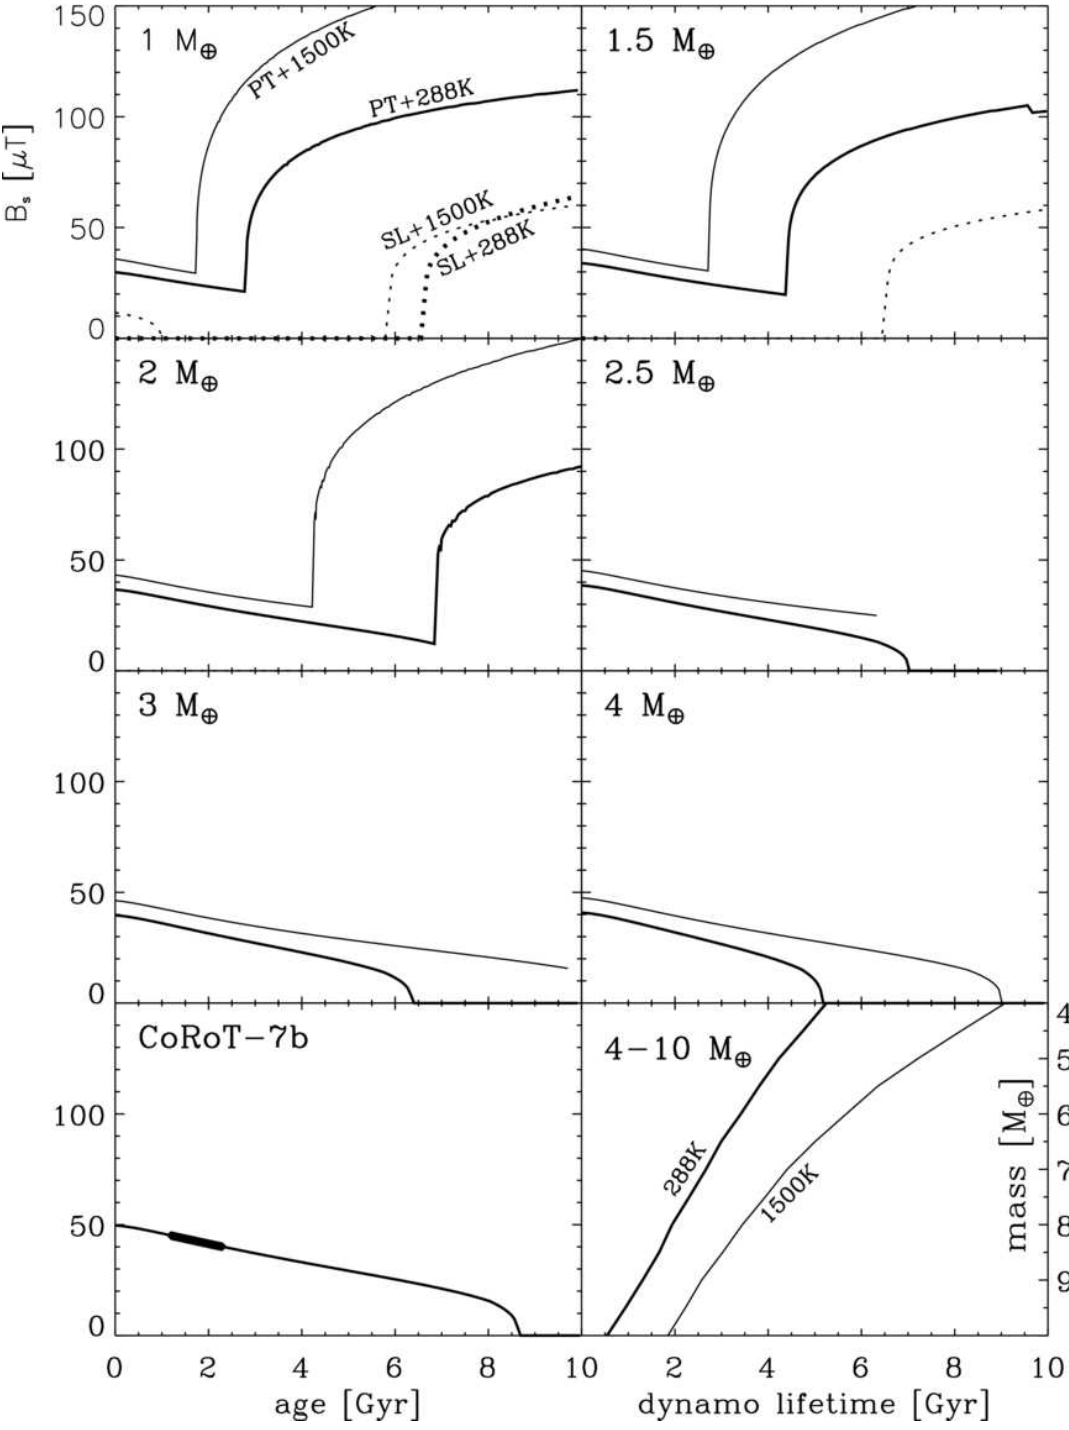
Figure 6. Evolution of the surface PMF of planets with masses of 1–10 M ⊕ and the ∼ 4.8 M ⊕ planet CoRoT-7b. Absence of a line indicates that the dynamo is inoperative. Dynamos are assumed dipolar. Heavy solid lines: Earth-like planets with plate tectonics and T = 288 K. s Light solid lines: a hot Earth with plate tectonics and T = 1500 K. Light dashed lines: Venus-like planets with stagnant lid, 10 times the s Earth’s mantle viscosity, and T = 1500 K. Heavy dashed lines: a balmy Venus with T = 288 K. For the case of CoRoT-7b, T ≈ 1810 K, s s s assuming eflcient redistribution of heat (Léger et al. 2009). The thick part of the CoRoT-7 curve spans the range of the system’s estimated age (1.1 to 2.3 Gyr). The bottom right-hand panel is the evolution of dynamos as a function of mass > 4 M and the two values of the surface ⊕ temperature.(Figure from GA10, with permission of the